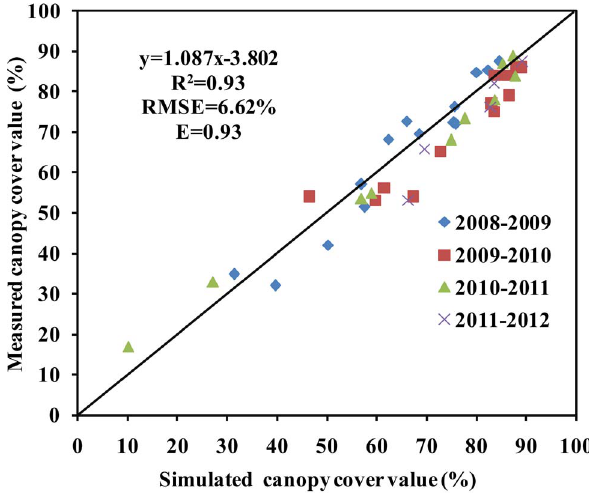
Figure 3. Relationship between the measured and simulated canopy cover (CC) in winter across 4 years. Note: x represents the simulated CC, y represents the measured CC. The intercept represents the relative error between the simulated CC and the measured CC. The slope represents the consistency between the simulated CC and the measured CC.